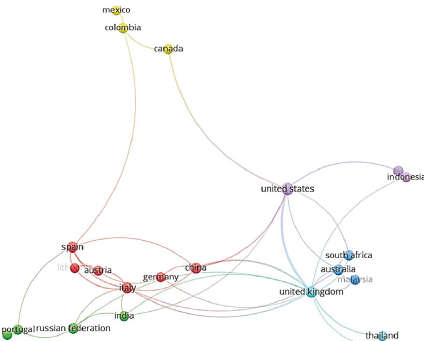
Figure 7: Networks of collaborations by countries. Source: